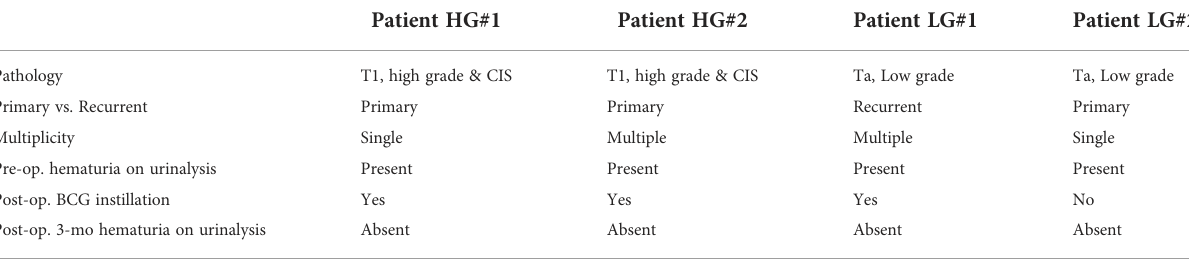
TABLE 1 Clinical parameters of patients used for screening urinary EV-in the protein array after transurethral